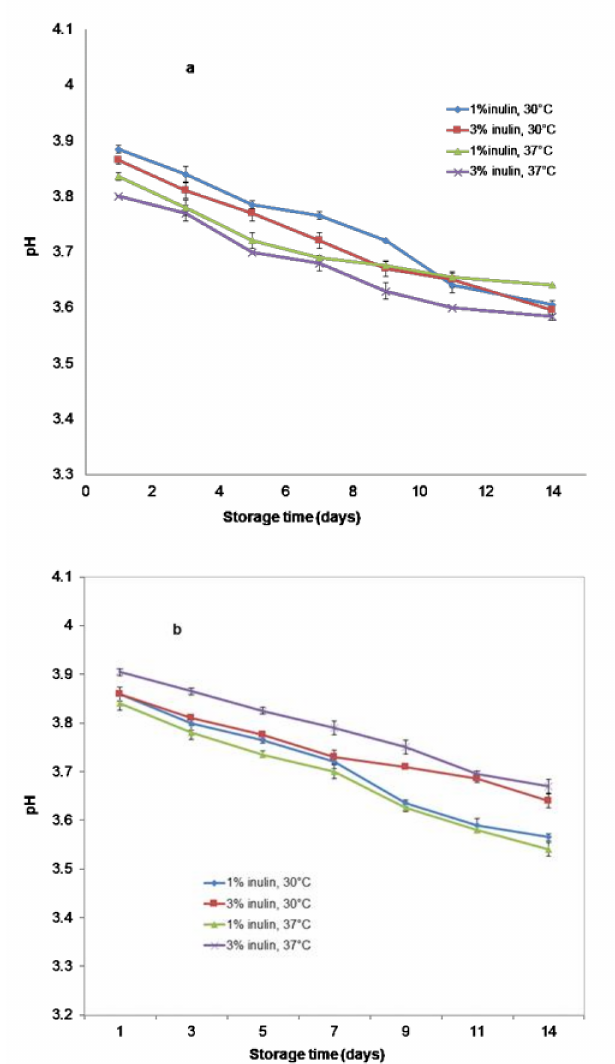
Figure 5. pH changes in beverages during storage. ( a ) Samples with SBS; ( b ) Samples with